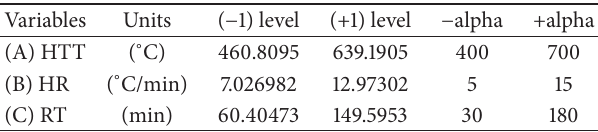
Table 1: Level of different